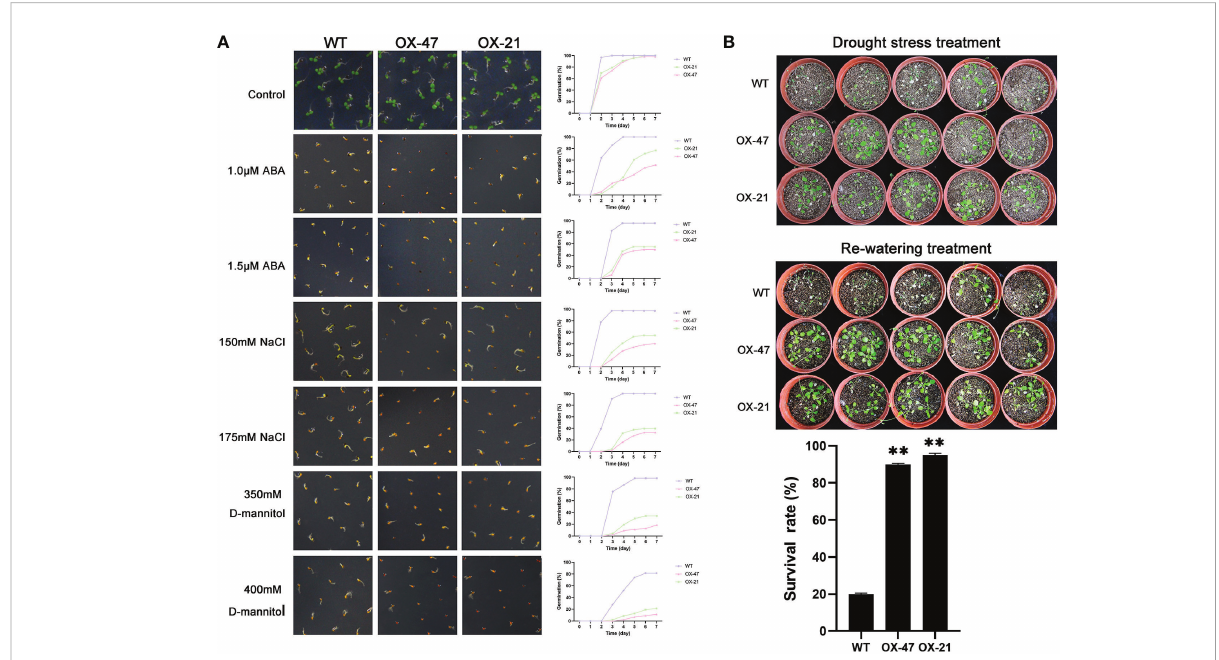
FIGURE 5 Germination and phenotype analysis ZmNAP overexpressing Arabidopsis. (A) Germination assays of ZmNAP were performed under the presence of 1.0 m M and 1.5 m M ABA, 150 mM and 175 mM NaCl, 350 mM and 400 mM D-mannitol. Data are means ±SD of three biological replicates. (B) Performance and survival rate of the ZmNAP overexpressing lines under drought stress and re-watering treatments. Three biological replicates and calculate the average. Highly signi fi cant differences (P < 0.01) were represented by